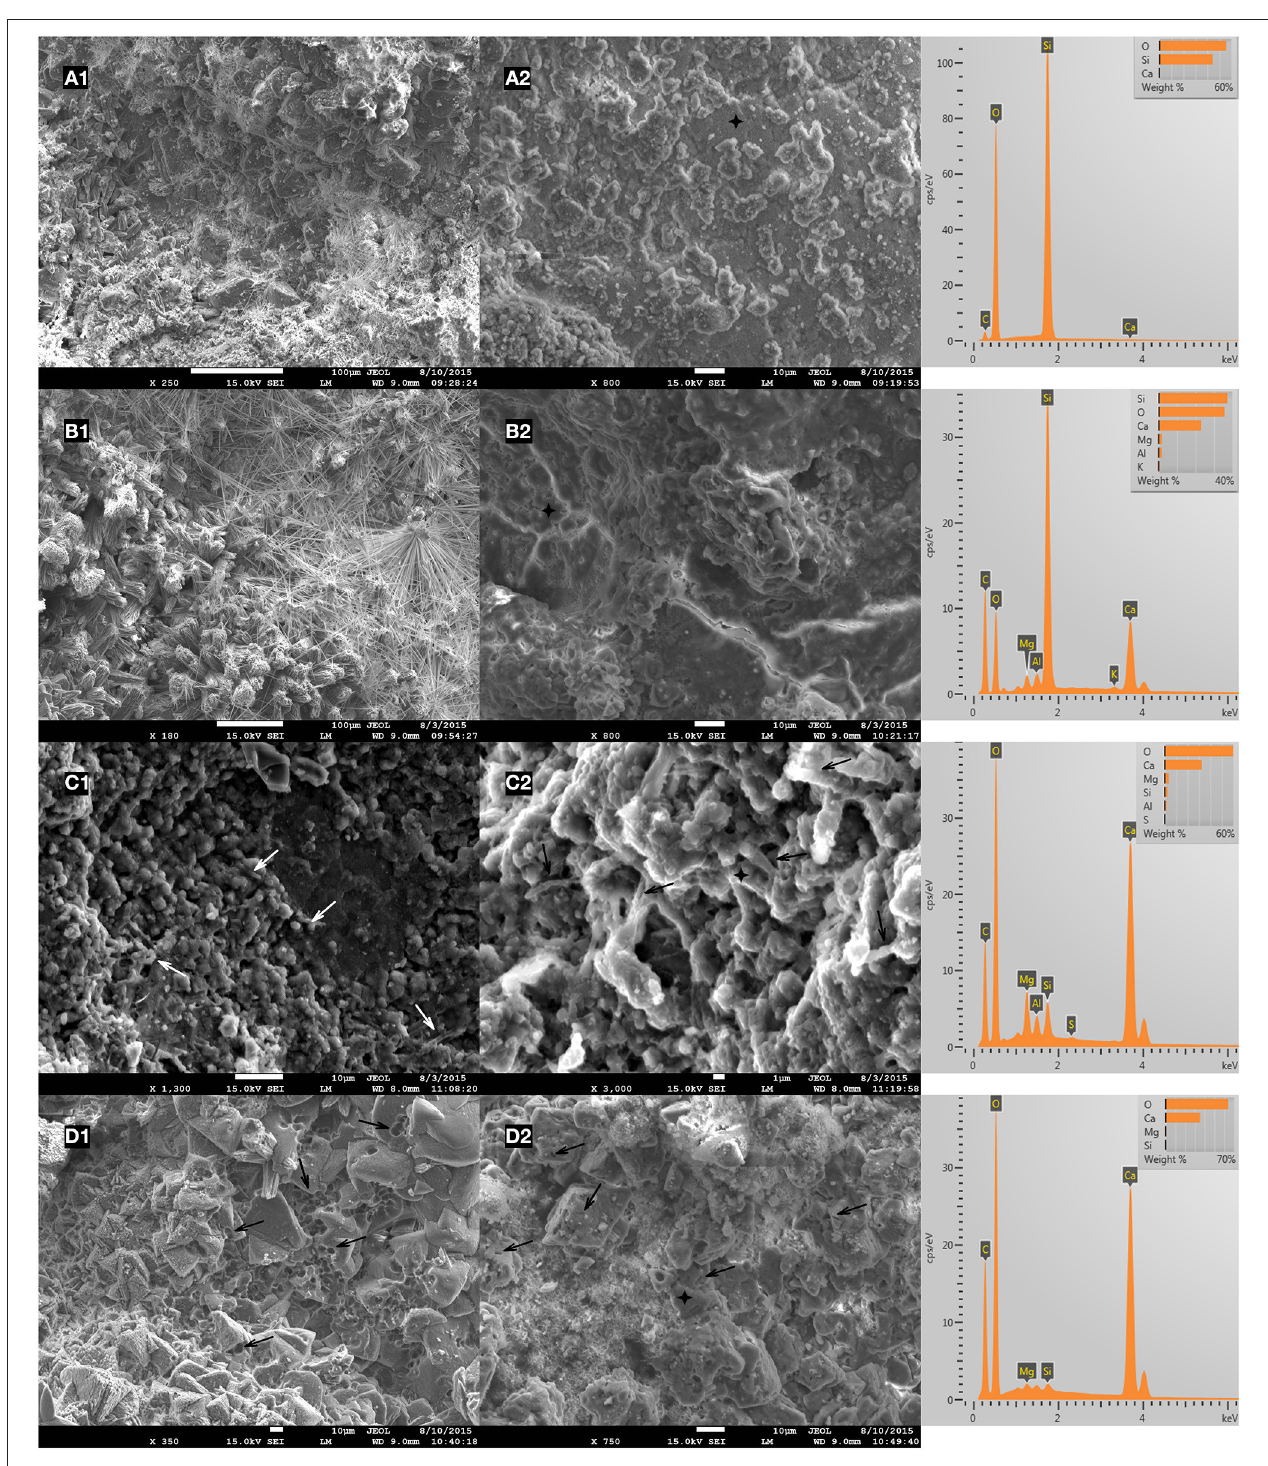
FIGURE 12 | Representative SEM micrographs and EDX analysis of the dominant healing material on the inner crack surface of 6 months old specimens after 28 days of healing (A1,A2) reference mortar; (B1,B2) abiotic control (reference + 5% nutrients); (C1,C2) mortar containing 0.5% ACDC and 5% nutrients; (D1,D2) mortar containing 1% ACDC and 5% nutrient [Nutrients – 2% Ca(HCOO) 2 + 3% Ca(NO 3 ) 2 ; weight percentages are in terms of cement weight; “ ր ” indicates the calcified bacterial remains; “ + ” indicates the points analyzed via EDX].